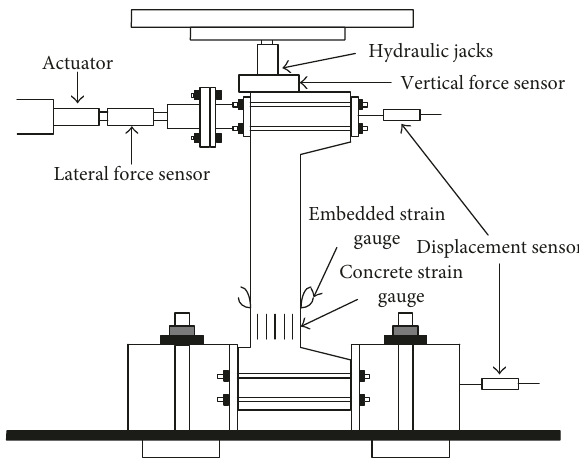
Figure 4: Setup of low cyclic loading tests.